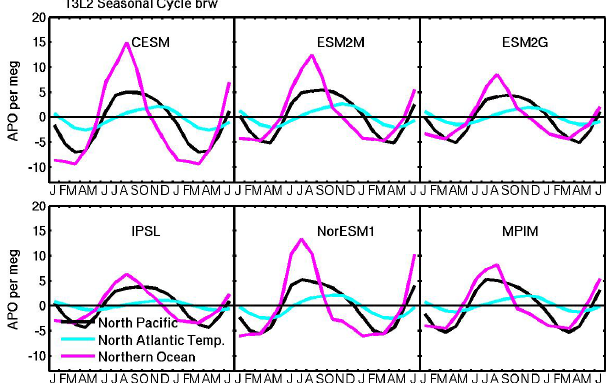
Figure 3. Partitioning the APO cycle at Barrow, Alaska, into its main regional contributions, North Pacific (black), temperate North Atlantic (cyan) and Northern Ocean (magenta), which includes the North Atlantic north of 48 ◦ N and the Arctic Ocean. All curves re- flect the unscaled model mean of the 13 ATMs used in the matrix